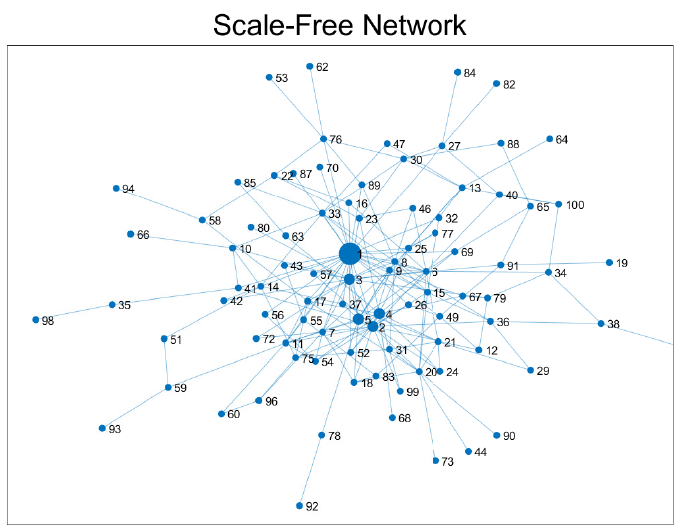
Figure 2. A diagram of a scale-free network is displayed with 100 individuals. A typical high level of heterogeneity in degree distribution (or contact numbers) is